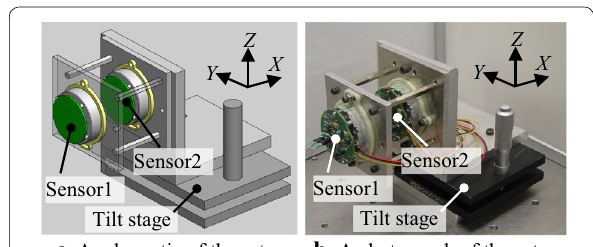
Figure 8 A setup for evaluation of sensor linearity